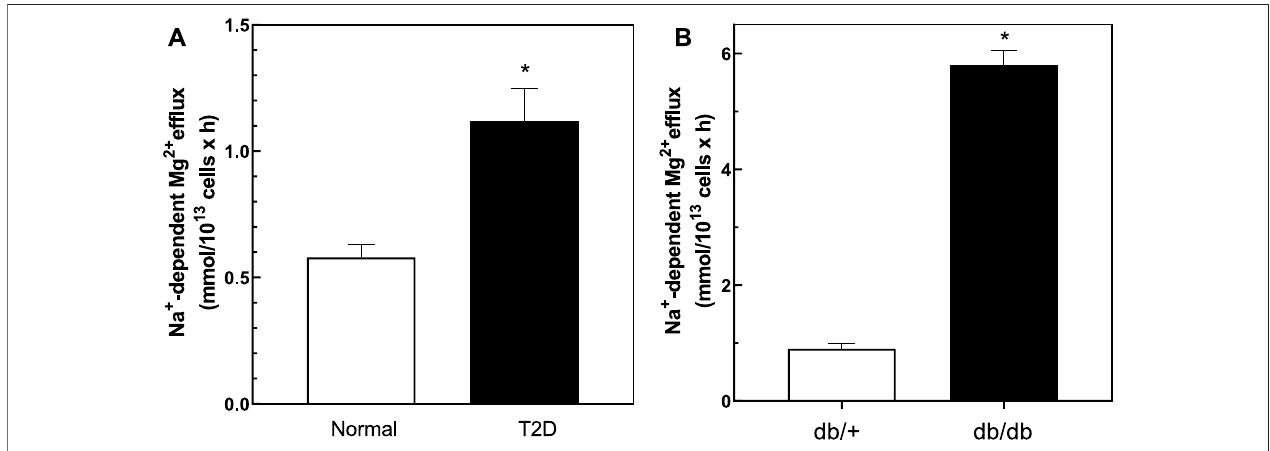
FIGURE3| BaselineNa + /Mg 2+ exchangeractivityincellsfromnormalandtype2diabetichumansubjectsanddb/dbanddb/+mice.Cellswereusedtodeterminethe activityoftheNa + /Mg 2+ exchangerasdescribedinMethods. (A) Na + /Mg 2+ exchangeractivityincellsfromnormalandT2Dhumansubjects( n =33and n =30innormaland diabetic subjects, respectively; * unpaired t test, p < 0.001). (B) Na + /Mg 2+ exchanger activity in red cells from diabetic db/db and non-diabetic db/+ mice ( n = 3); * unpaired t test nonparametric, p < 0.01). Results are expressed as means ± SEM of three experiments in triplicate determinations.